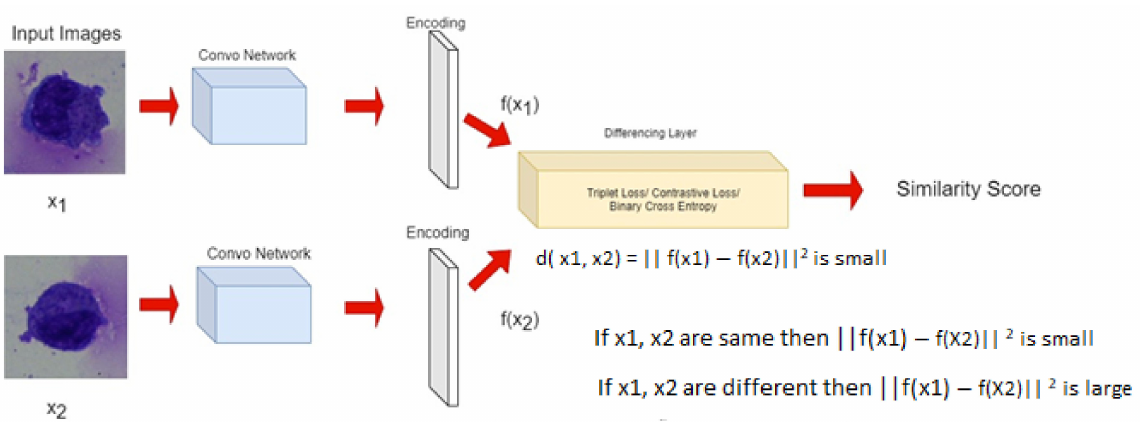
Figure 9. Block diagram illustrating end to end traversal in model right from the input of paired